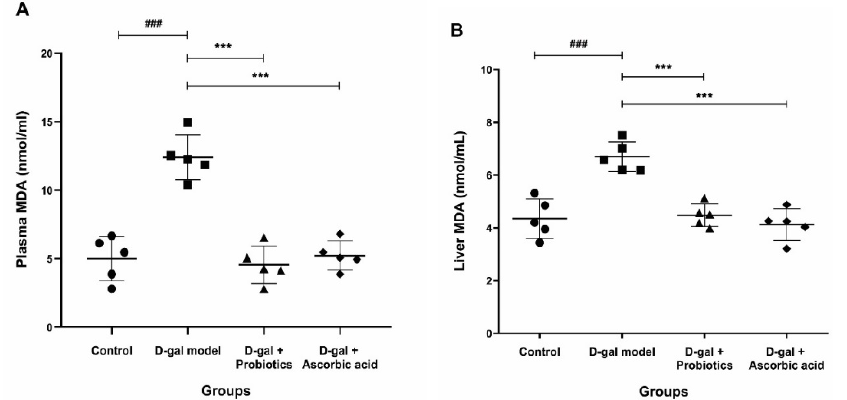
Figure 3. Effect of B. animalis MSMC83 or ascorbic acid on the plasma and liver malondialdehyde (MDA) levels in oxidative stress rats. Plasma MDA ( A ), liver MDA ( B ). ● , ■ , ▲ , ◆ as individually in each group. ### p < 0.001 as compared with the control group. *** p < 0.001 as compared with the D-gal model group ( n = 5).